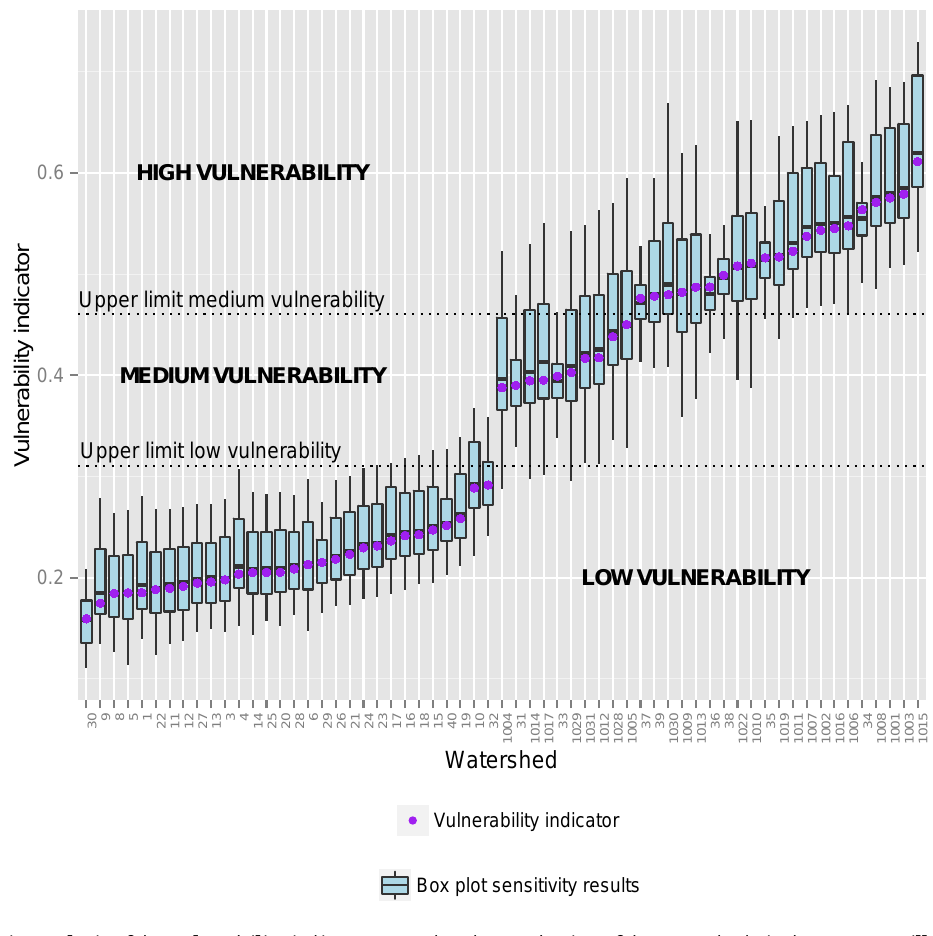
Figure 8. Sensitivity analysis of the vulnerability indicator. Note that the numbering of the watersheds in the Eastern Hills goes from 1 to 40 and in the Tunjuelo River basin from 1000 to